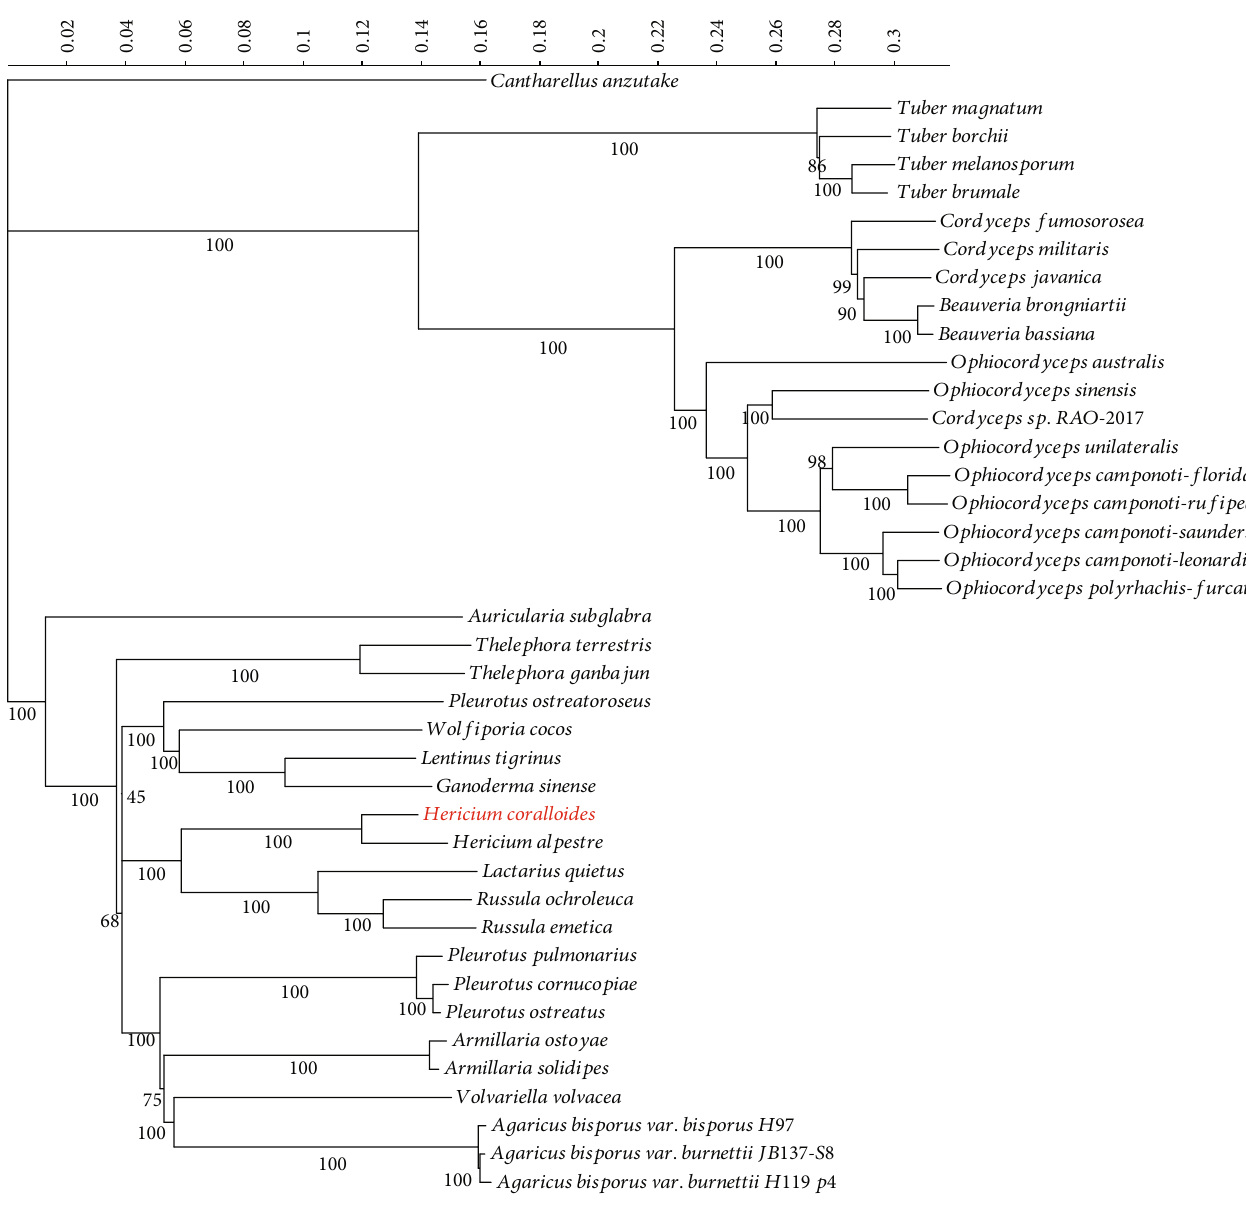
Figure 6: The phylogenetic tree based on single-copy ortholog genes between H. coralloides and 39 other fungal